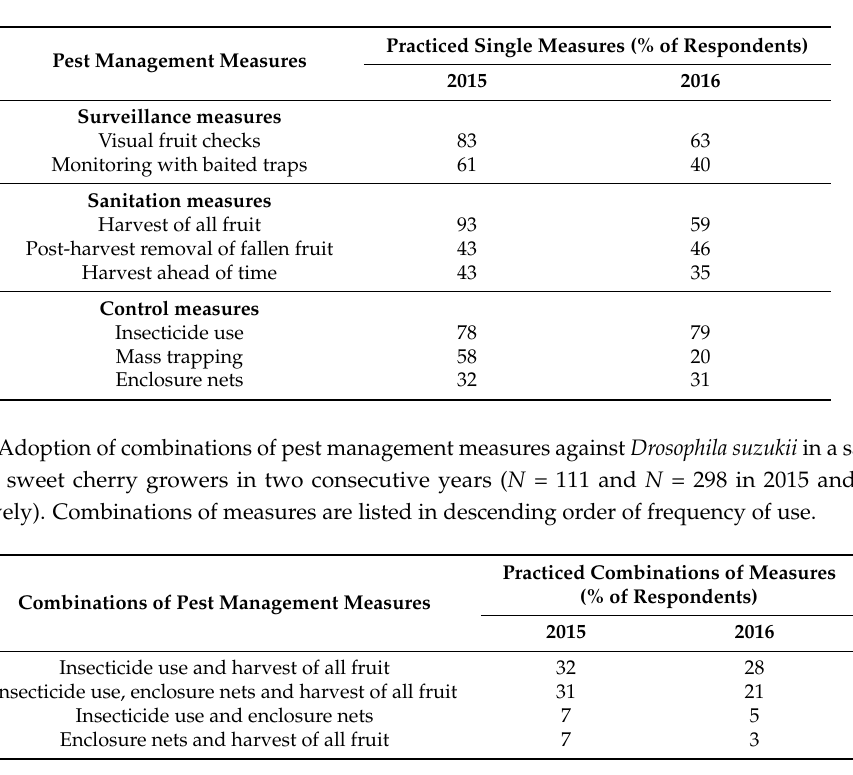
Table 3. Adoption of single pest management measures against Drosophila suzukii in a sample of Swiss sweet cherry growers in two consecutive years ( N = 111 and N = 298 in 2015 and 2016, respectively). Measures are listed in descending order of frequency of use.